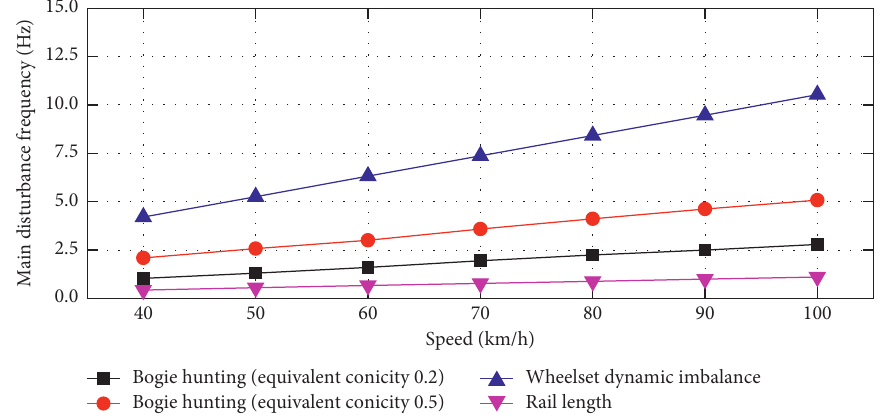
Figure 6: Main disturbance frequency of test metro.